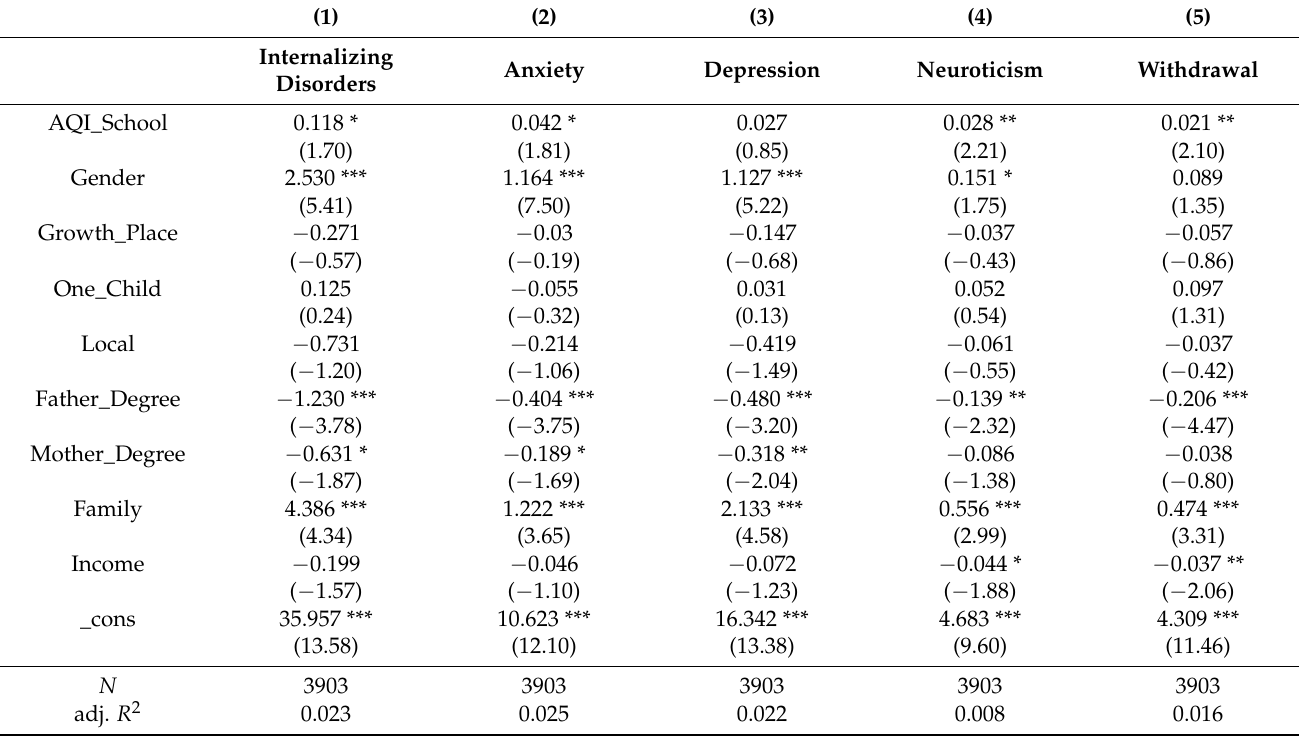
Table 5. The tests of mediating mechanisms: Step